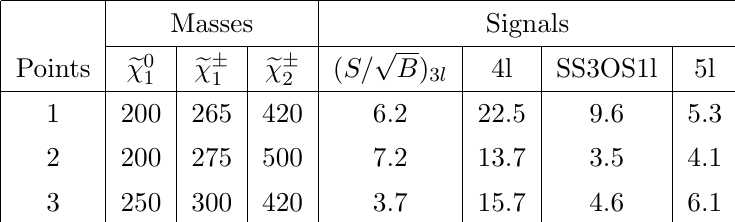
BP3-DM the 3 l signal is unobservable whereas for the (cid:12)rst and the last BP the 4 l signal is likely to be observed. It is interesting to note that for all other BPs the 3l signal is observable. Thus if the 4l signal (and not the 3l signal) is observed BP1-DM and BP3-DM would be strong candidates for the underlying physics. These two models, in turn, can